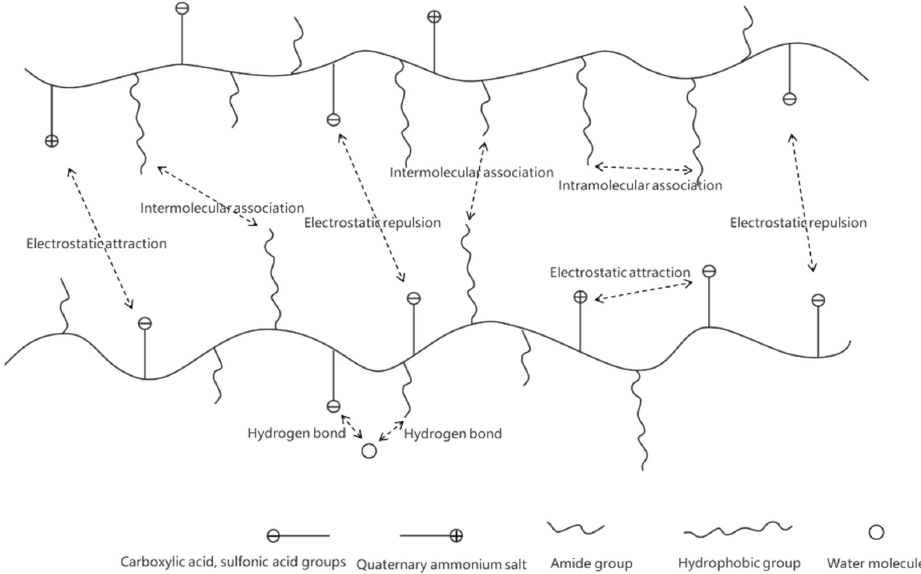
Figure 7. Associations in the ZJL-1.